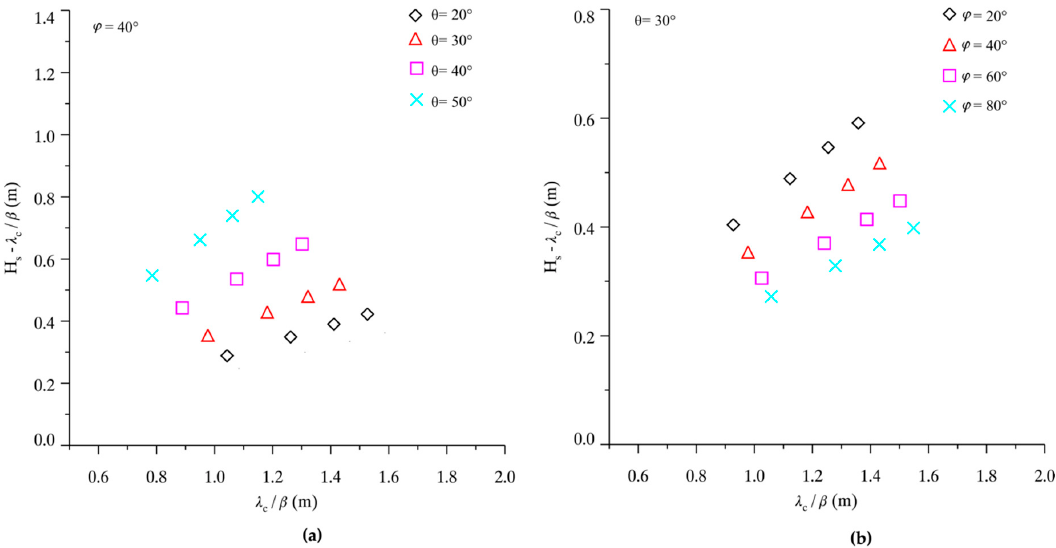
Figure 5. < λ c / β > that is defined as the bias between H s from Jonswap simulation and value of λ c / β calculated by Equation (5), versus λ c / β . ( a ) Wave propagation direction relative to the range direction ϕ is fixed at 40° and the radar incidence angle θ varies from 30° to 60° at an interval of 10°; and ( b ) θ is fixed at 30° and ϕ varies from 20° to 80° at an interval of 20° clockwise.